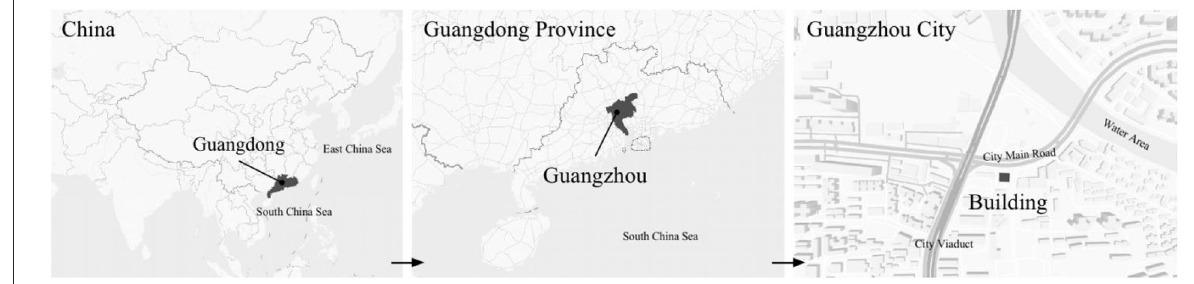
FIGURE1 Location characteristics of experimental building.